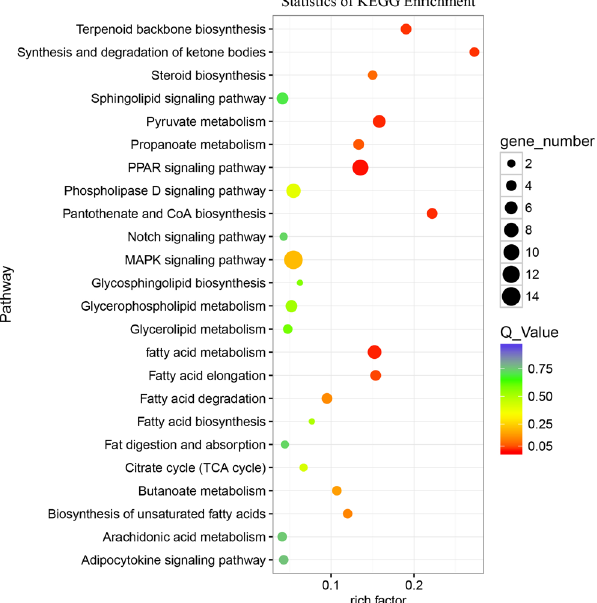
Figure 3. KEGG pathway analysis of differentially expressed genes. Advanced bubble chart shows enrichment of differentially expressed genes in signaling pathways. Y-axis label represents pathway, and X-axis label represents rich factor (rich factor = amount of differentially expressed genes enriched in the pathway/amount of all genes in background gene set). Size and color of the bubble represent amount of differentially expressed genes enriched in pathway and enrichment significance,